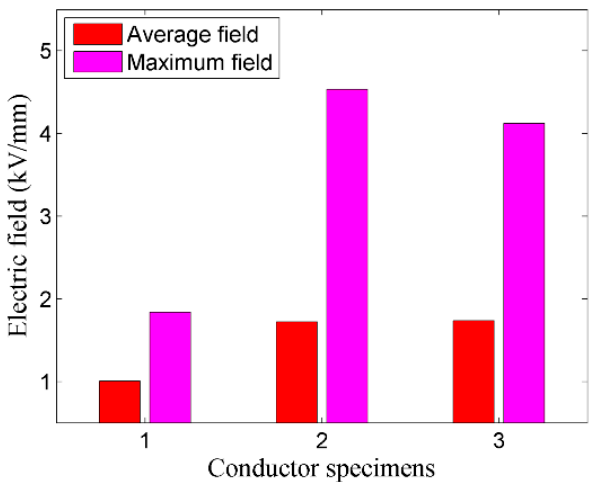
Figure 5. Location and magnitude of the maximum electric field for the proposed pliable GIL regarding ( a ) specimen 2 and ( b ) specimen 3 of Table 2.